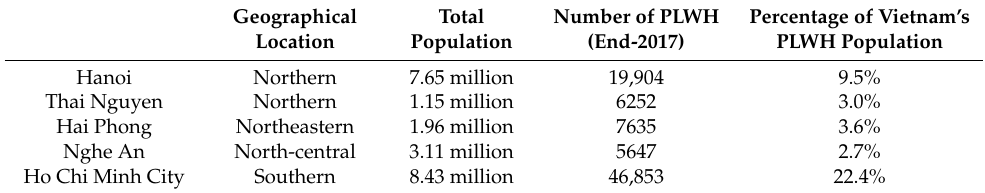
Table 1. Summary of study settings. The number of people living with HIV (PLWH) by geographical